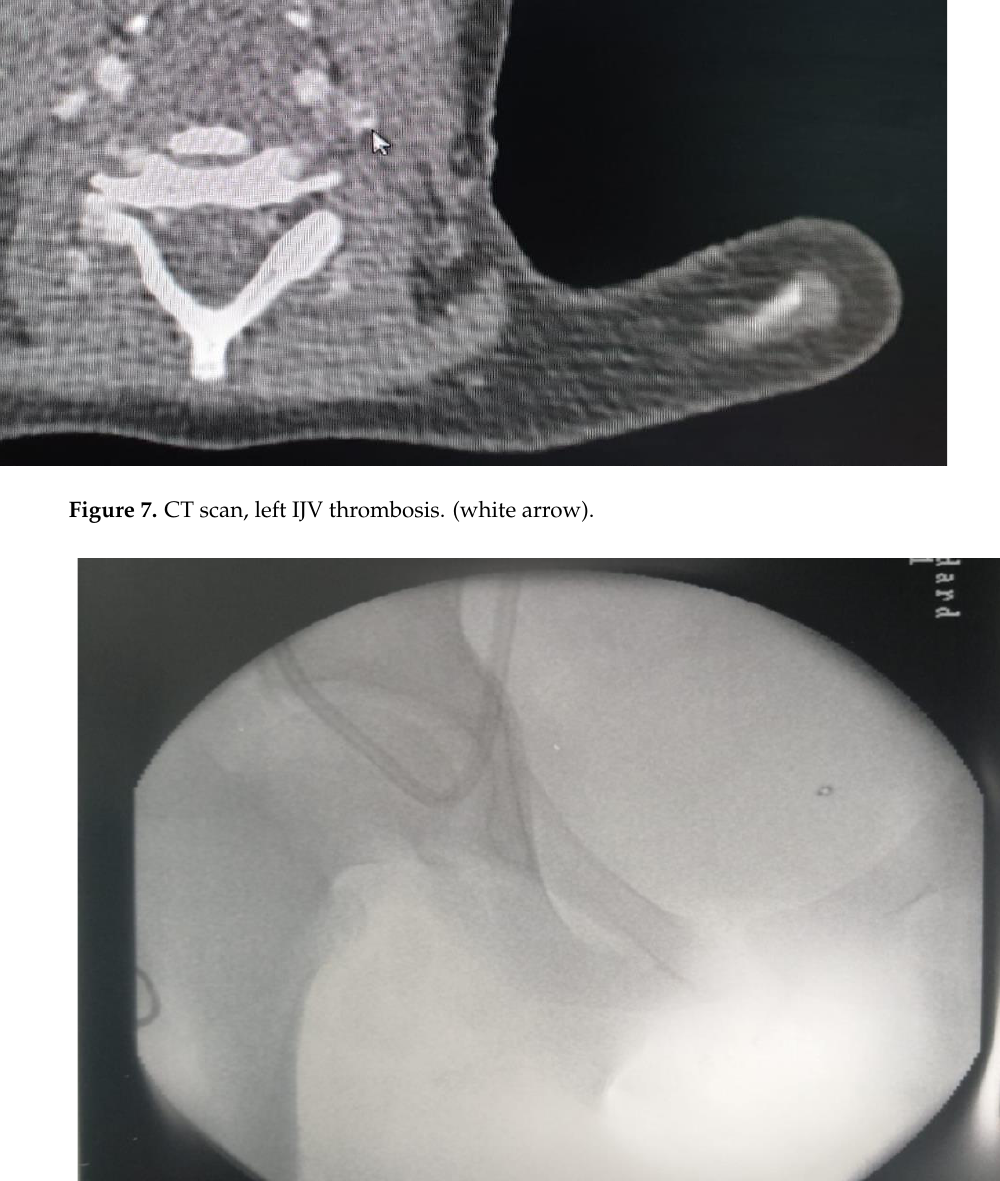
Figure 8. C arm X-ray — Unusual placement of CVC in the epigastric vein for chronic hemodialy-